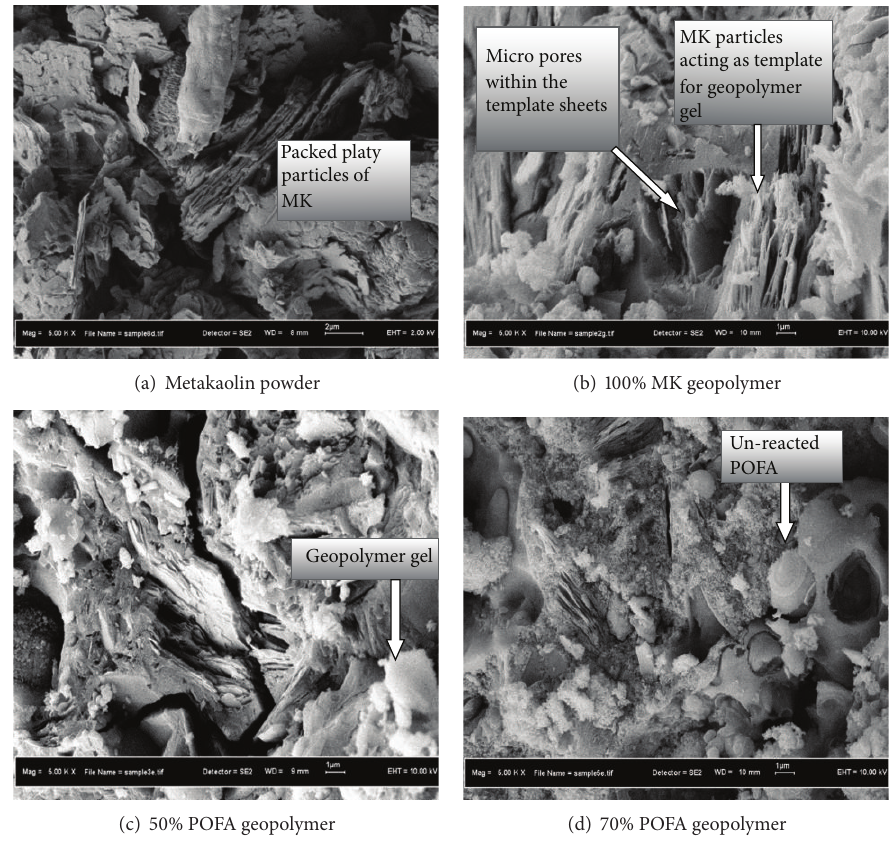
Figure 4: FESEM of metakaolin powder and geopolymer specimens.